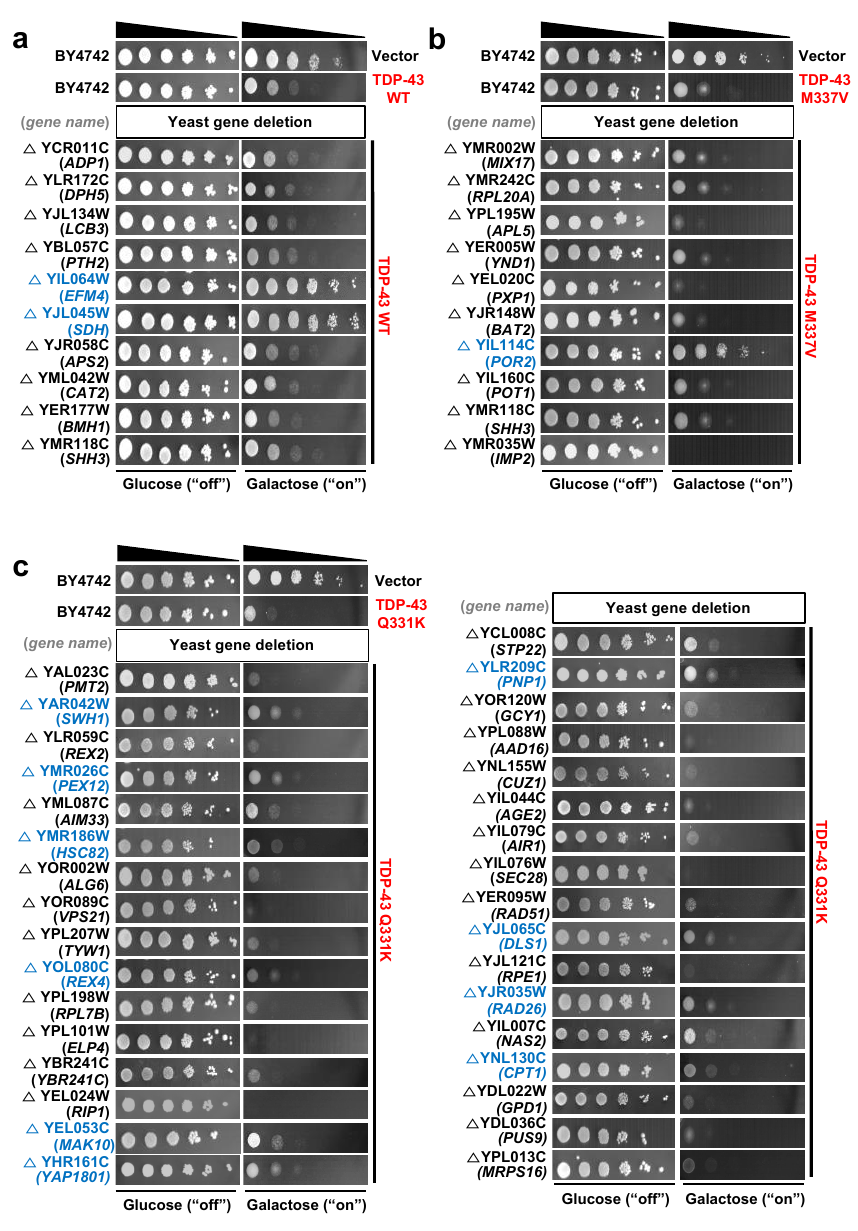
Figure 1. Validation of toxicity suppressors by yeast spotting assays. Based on the analysis of Bar-seq data and Z-score distributions, the toxicity-suppressing yeast gene deletions were subjected to spotting assays. ( a – c ) Overexpression of wild-type (WT) ( a ) or mutant human TDP-43 ( b , c ) causes toxicity in yeast. Deletion strains marked in blue show toxicity-suppressing effects. The pAG425GAL-ccdB yeast destination vector was used as the control. The BY4742 yeast strain was used as the WT control. Table 1. List of TDP-43 genetic interaction candidates tested in the yeast spot assays. Geno-Type